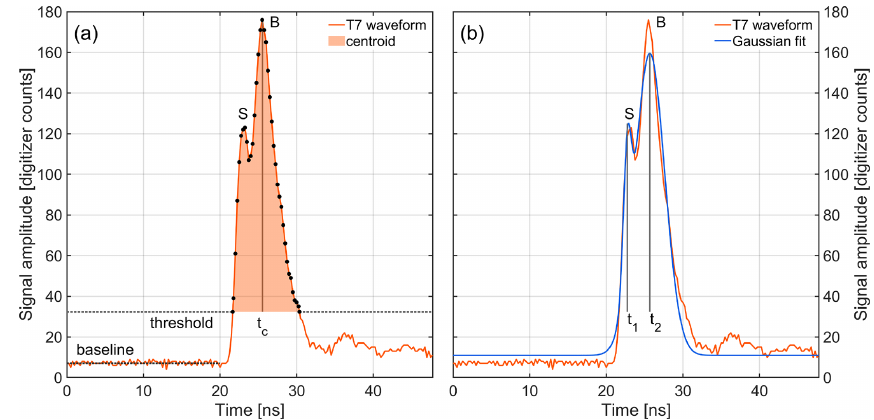
Figure 4. (a) Centroid estimate ( t c ) of overlapping surface (S) and bottom (B) return pulses. The centroid-based tracker returns an averaged slant range between the surface and bottom of the lake which in this case is close to the bottom return given the larger amplitude of the bottom return. (b) Gaussian fit of two peaks of overlapping surface (S) and bottom (B) return pulses. The slant range in water between the surface and bottom return pulses t 1 and t 2 is 33cm.